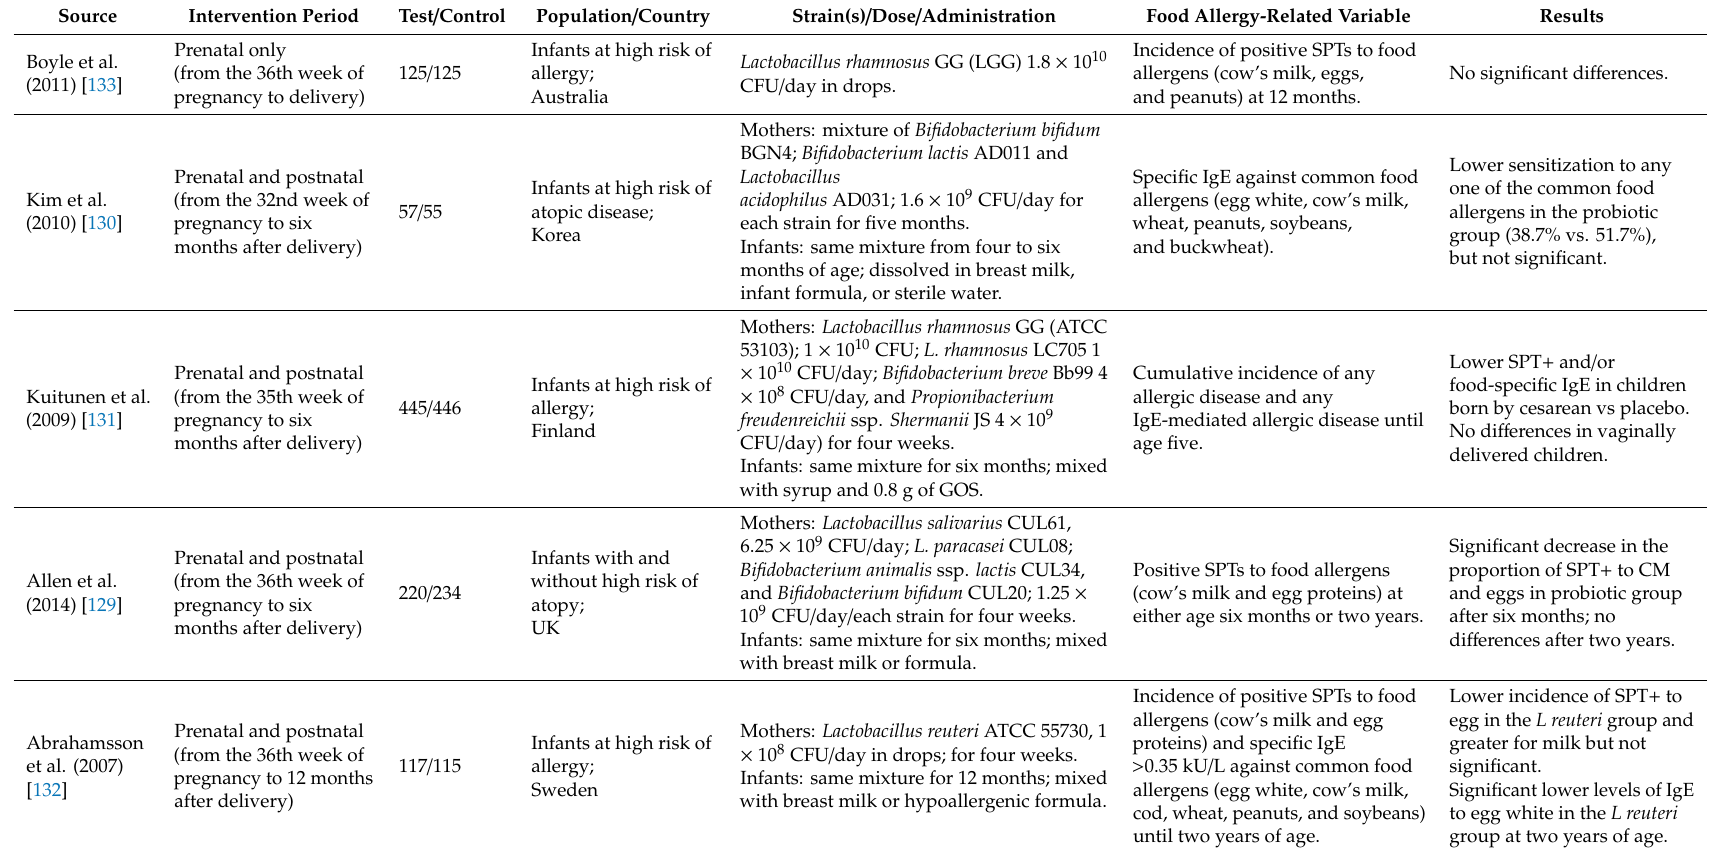
Table 2. Studies focused on the use of probiotics for the prevention of food sensitization in